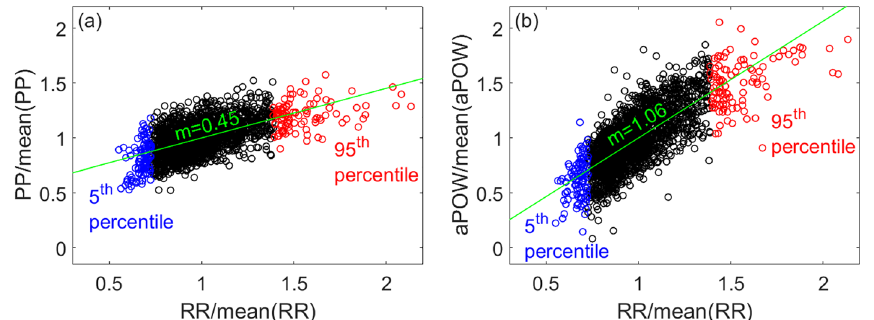
Figure 2. Examples of pre-ECV dispersion diagrams for a single patient: ( a ) PP(RR) and ( b ) aPOW(RR) normalized with the corresponding mean values (linear regression slopes m are indicated in green). 95th and 5th percentile subsets in red and blue, respectively.